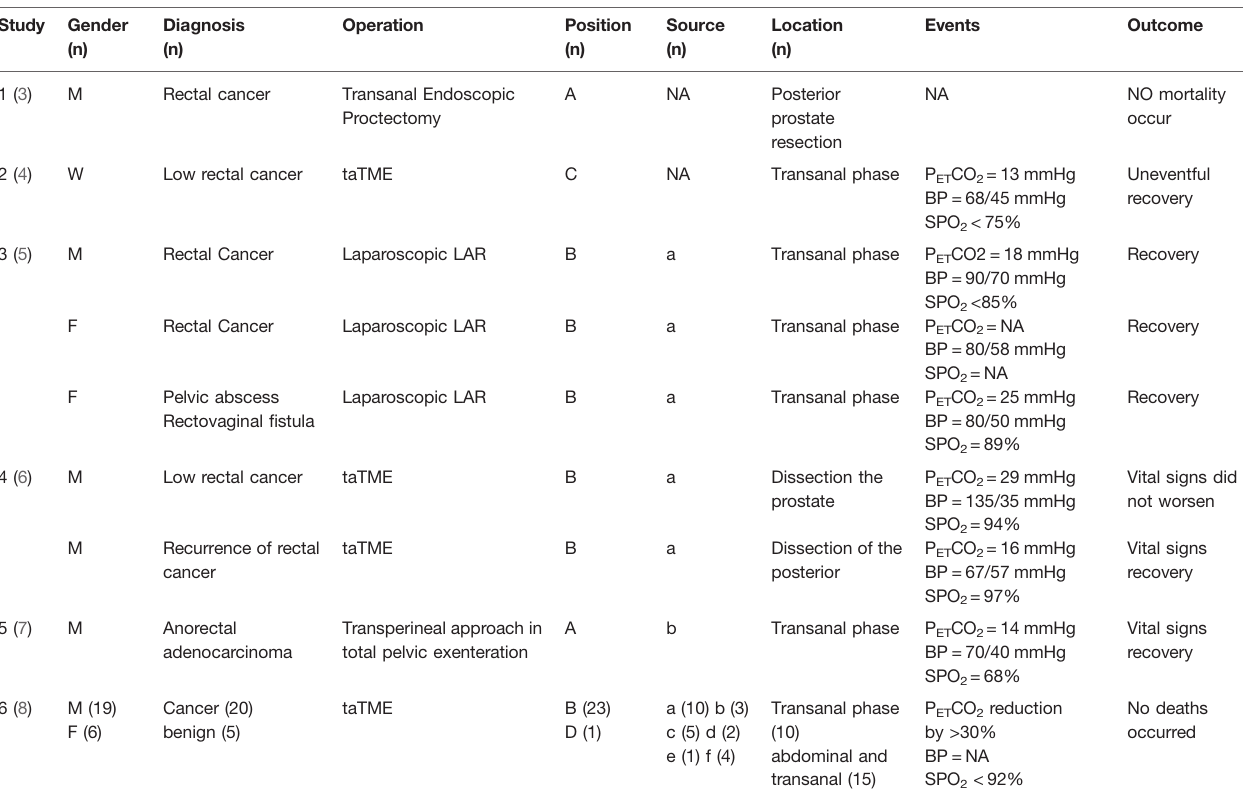
TABLE 1 | Clinical case reports of CO 2 embolism during